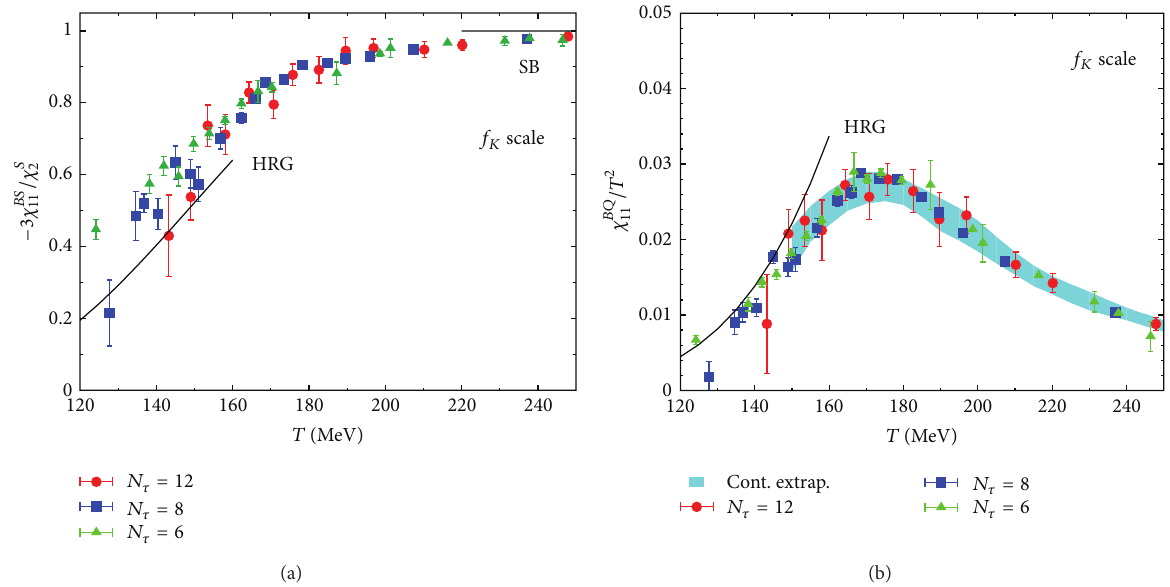
Figure 14: The HISQ data for 𝐶 𝐵𝑆 (a) and 𝜒 𝐵𝑄 11 /𝑇 2 (b) as a function of temperature, from